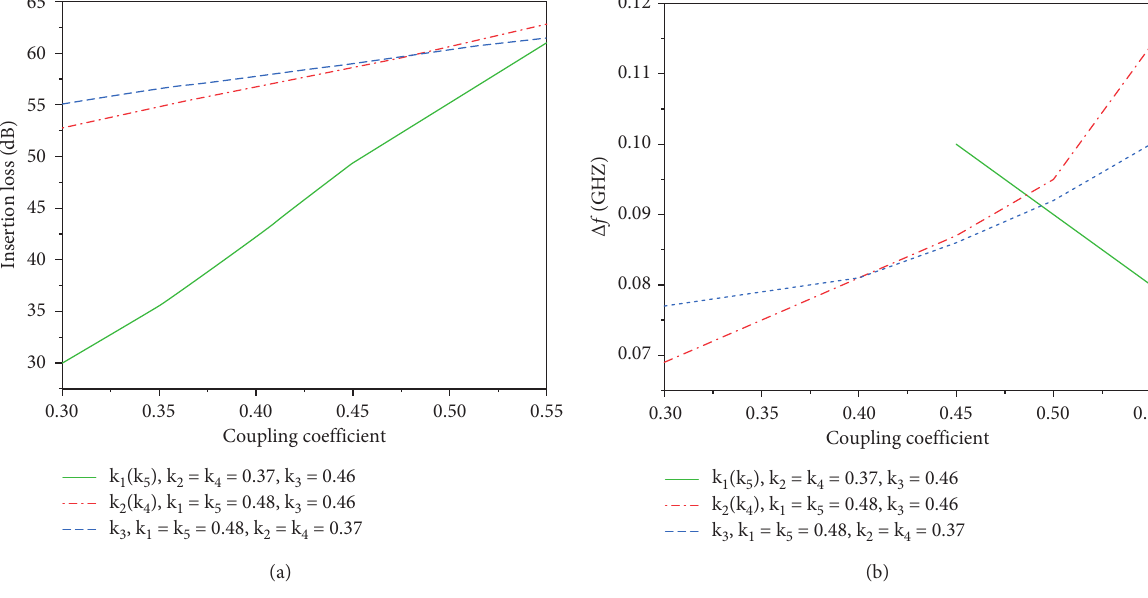
Figure 7: Simulation analysis: (a) the relationship between k 1 ( k 5 ), k 2 ( k 4 ), k 3 and maximum insertion loss; (b) the relationship between k 1 ( k 5 ), k 2 ( k 4 ), k 3 and bandwidth at insertion loss 50dB. Z 1 � Z 5 � 90 Ω , Z 2 � Z 4 � 66 Ω , and Z 3 � 81.3 Ω